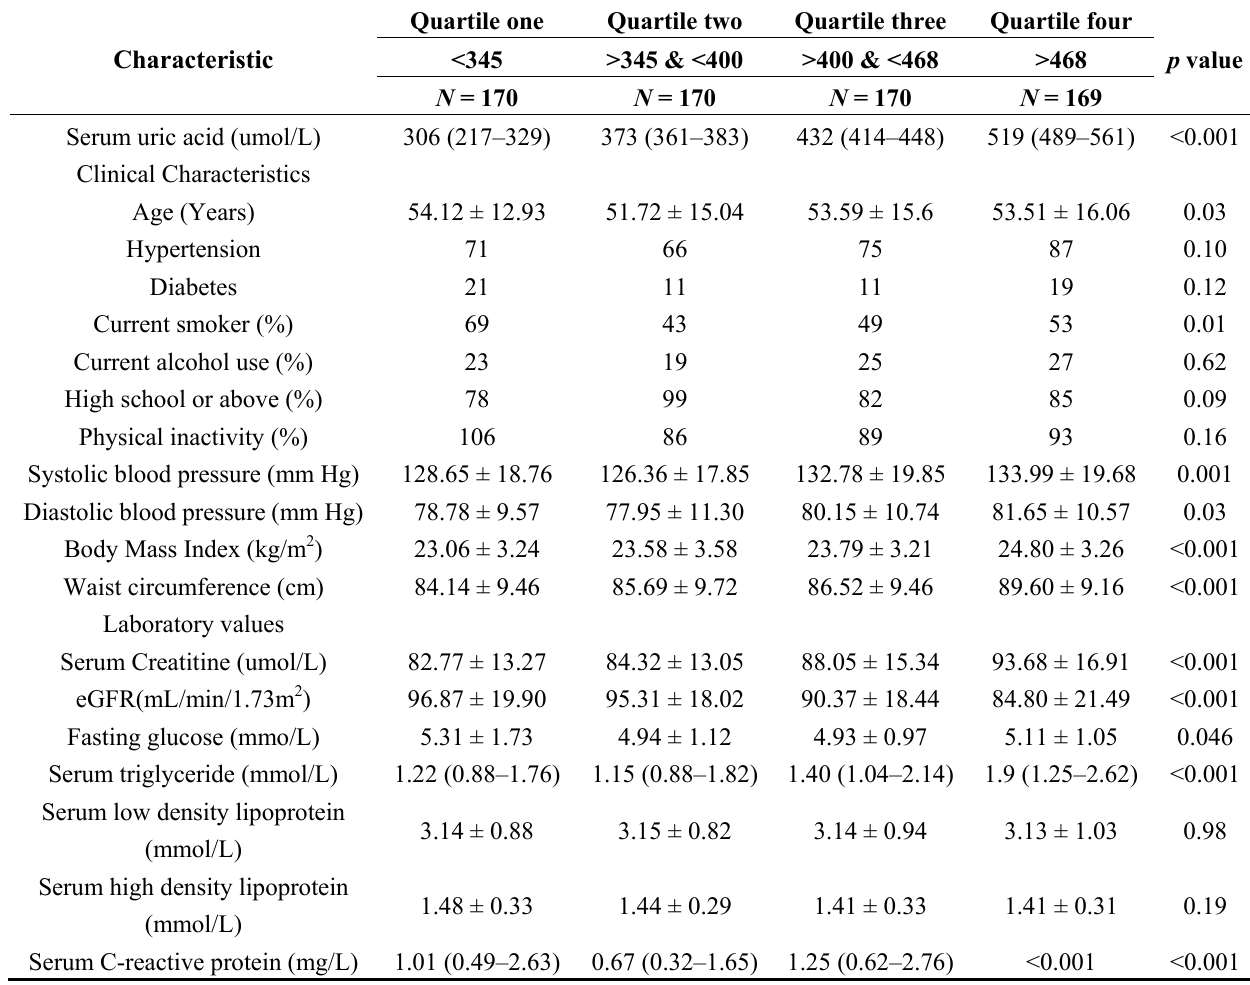
Table 1. Baseline characteristics of male subjects.